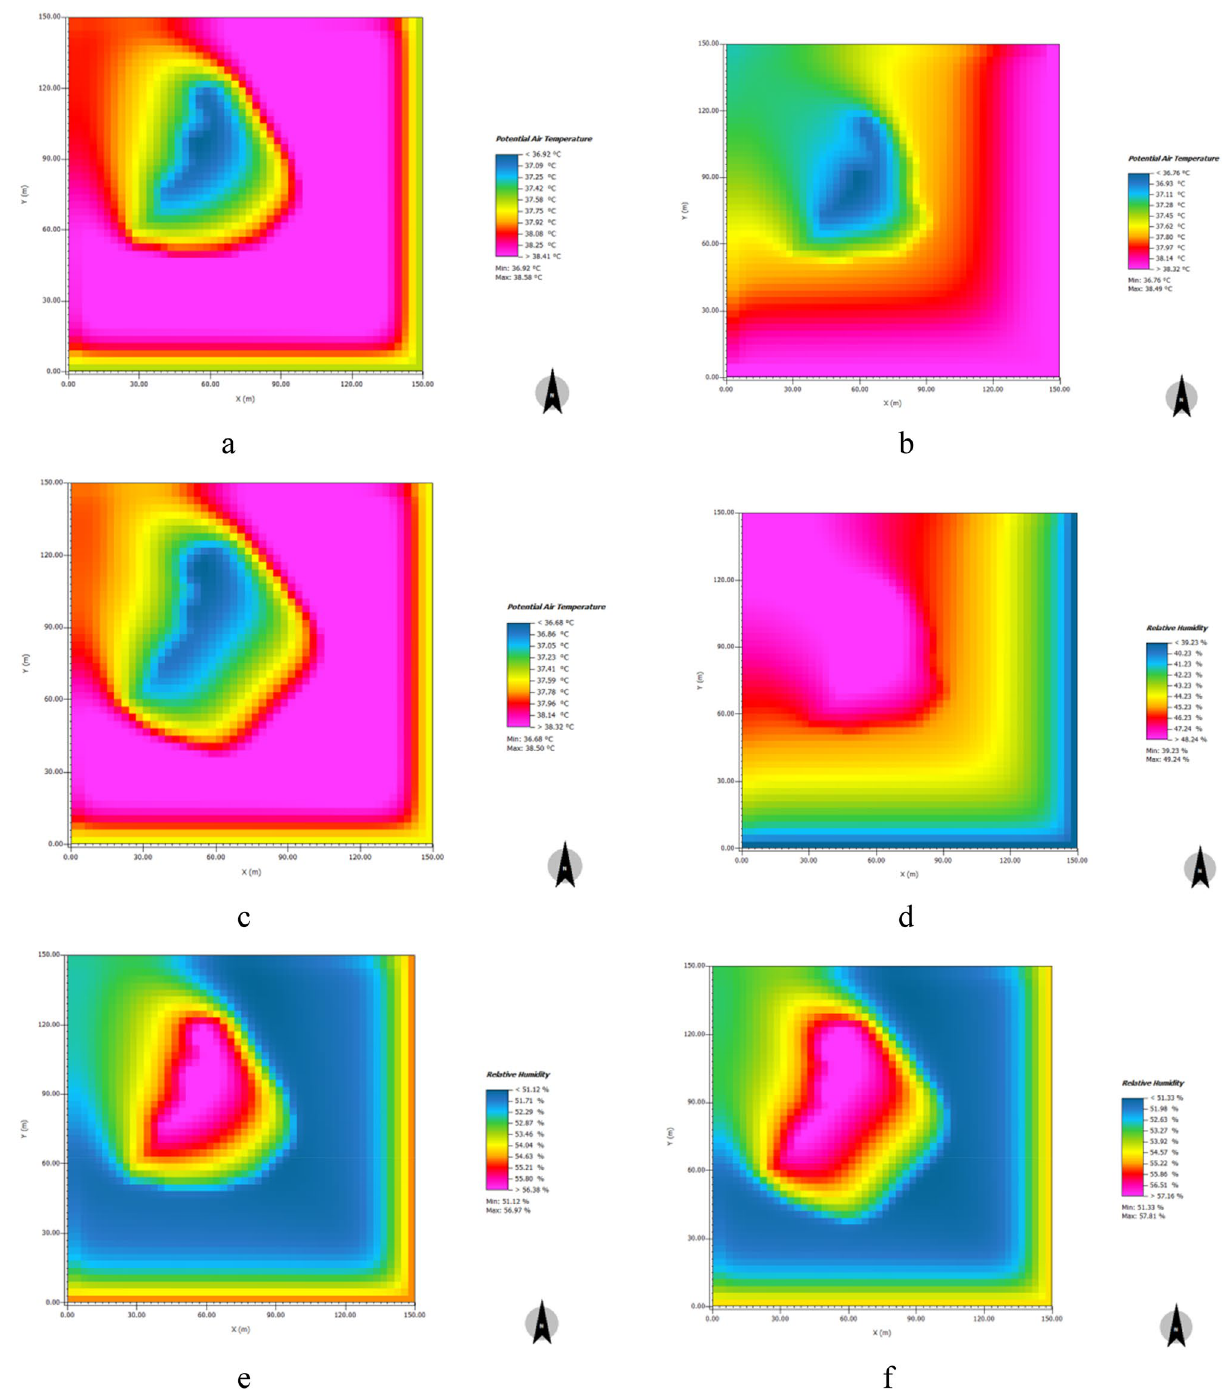
Figure 17. Distribution characteristics of cooling and humidifying effects of simulated increase of massive water area at 14:00. ( a ) original cooling effect of massive water in the sample area; ( b ) cooling effect of 5% increase in water area; ( c ) cooling effect of 10% increase in water area; ( d ) original humidifying effect of massive water in the sample area; ( e ) humidifying effect of 5% increase in water area; ( f ) humidifying effect of 10% increase of water